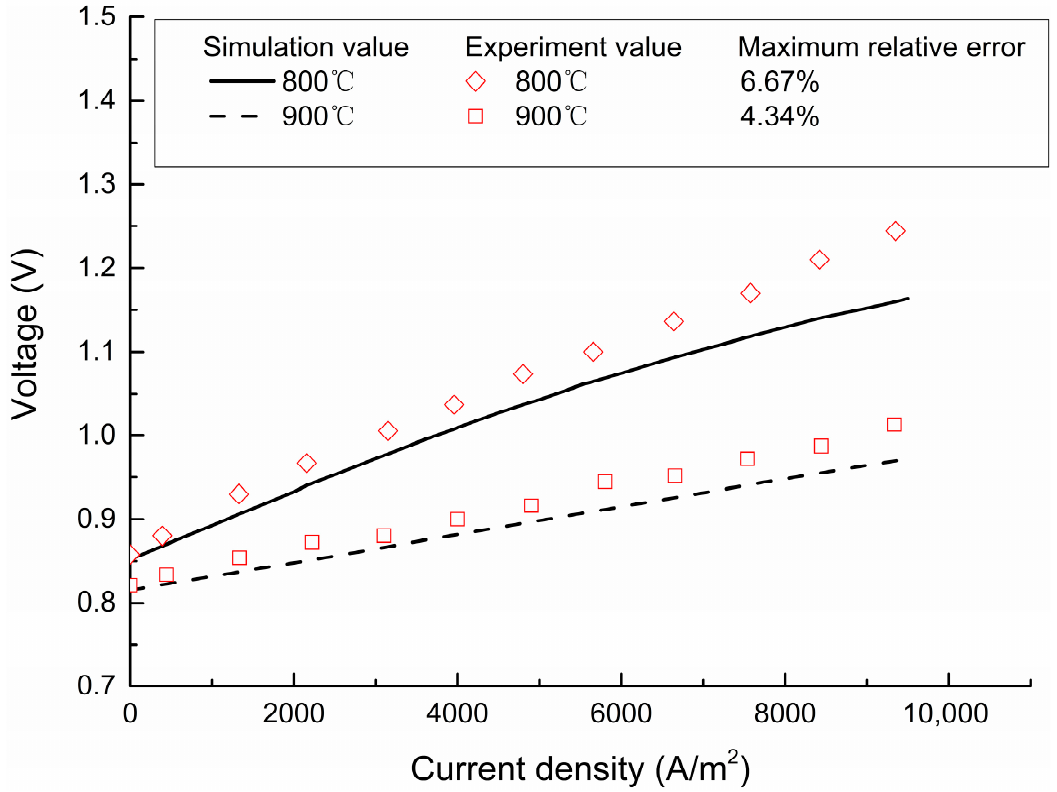
Figure 3. The result of model validation for SOECs.